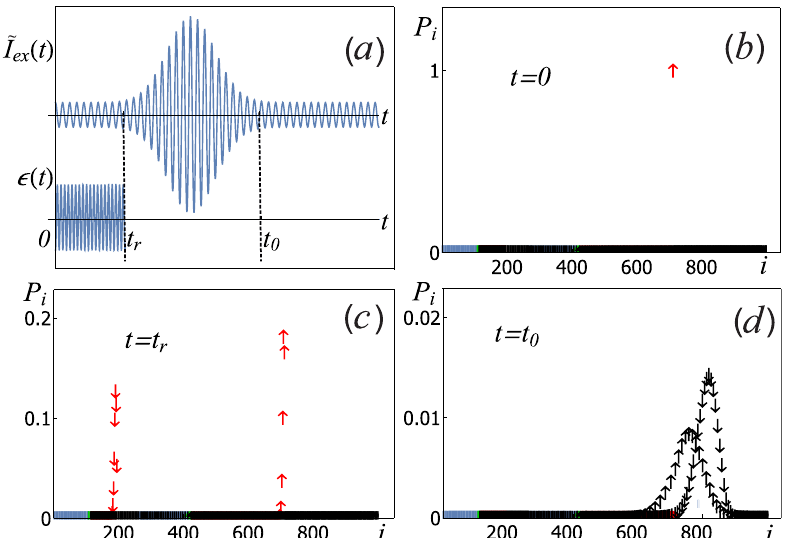
Figure 6. ( a ) Dependence of the average occupation number of the measuring oscillator n i = (cid:104) ψ i | a † a | ψ i (cid:105) as a function of the Hamiltonian (10) level numbers. The numbering of levels for each qubit state is chosen in descending order by energy (more details in [39]). The symbols ↑ and ↓ denote the system levels in which the qubit is in the ground state |↑(cid:105) and the excited state |↓(cid:105) , respectively. ( b ) The dependence of the probability of leaving the level i per unit time W i in units of 2 π g κ of leaving the level W i will be defined strictly on the next section). Four levels with values near W i = 0 correspond to the classical equilibrium points. The groups of levels related to the left and right equilibrium points (see Figure 2a) are shown in blue and red color, green color indicates the levels corresponding to the energy of the separatrix, and black color indicates the levels corresponding to the classical region in the phase space outside the separatrix. The system parameters are determined by the relations (6).